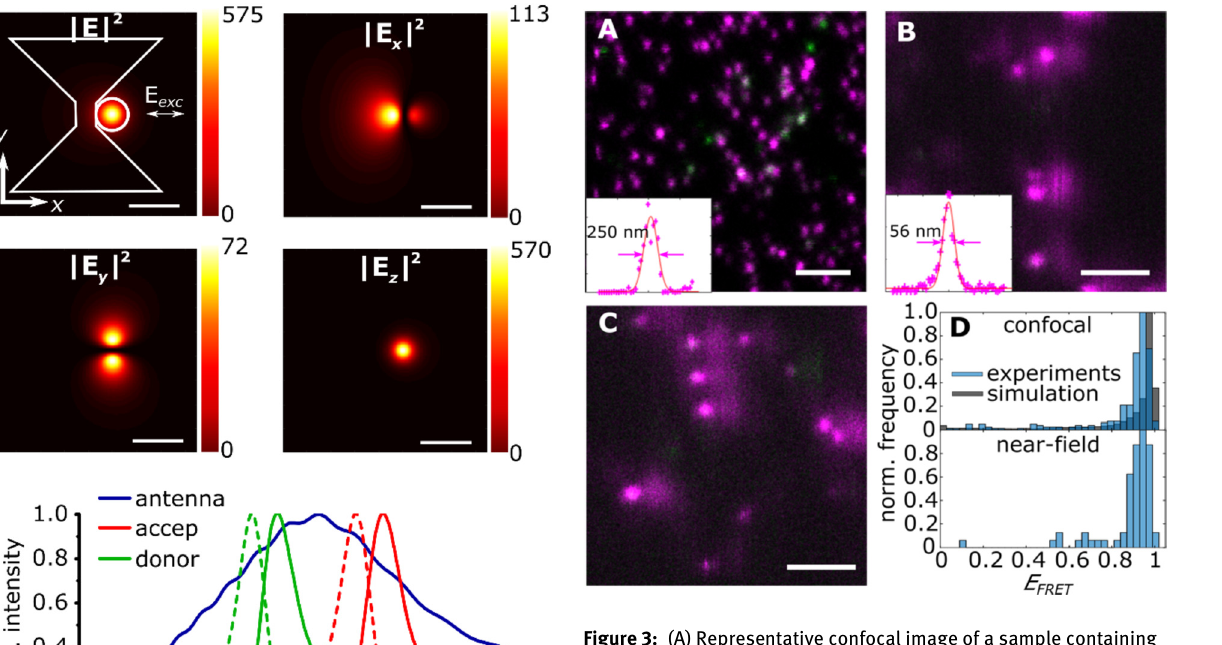
Figure 3: (A) Representative confocal image of a sample containing individual 3.4 nm FRET pairs. Magenta represents signal from the acceptorchannel(178counts/ms)andgreenfromthedonorchannel (55 counts/ms). Scale bar: 2 µm. Integration time: 2 ms per pixel. (B, C) Two exemplary antenna-based images of the same sample (with 181 counts/ms and 26 counts/ms in acceptor and donor channels respectively). Scale bar: 500 nm. Integration time: 10 ms per pixel. antenna (B) as compared to diffraction-limited confocal image (A). (D) Upper plot: E FRET histogram obtained from the mean intensity of individual spots from multiple confocal images (blue) together with simulated data considering all possible orientations between do- nors and acceptors (grey). Lower plot: Corresponding E FRET histo- gram obtained from individual spots over multiple antenna-based